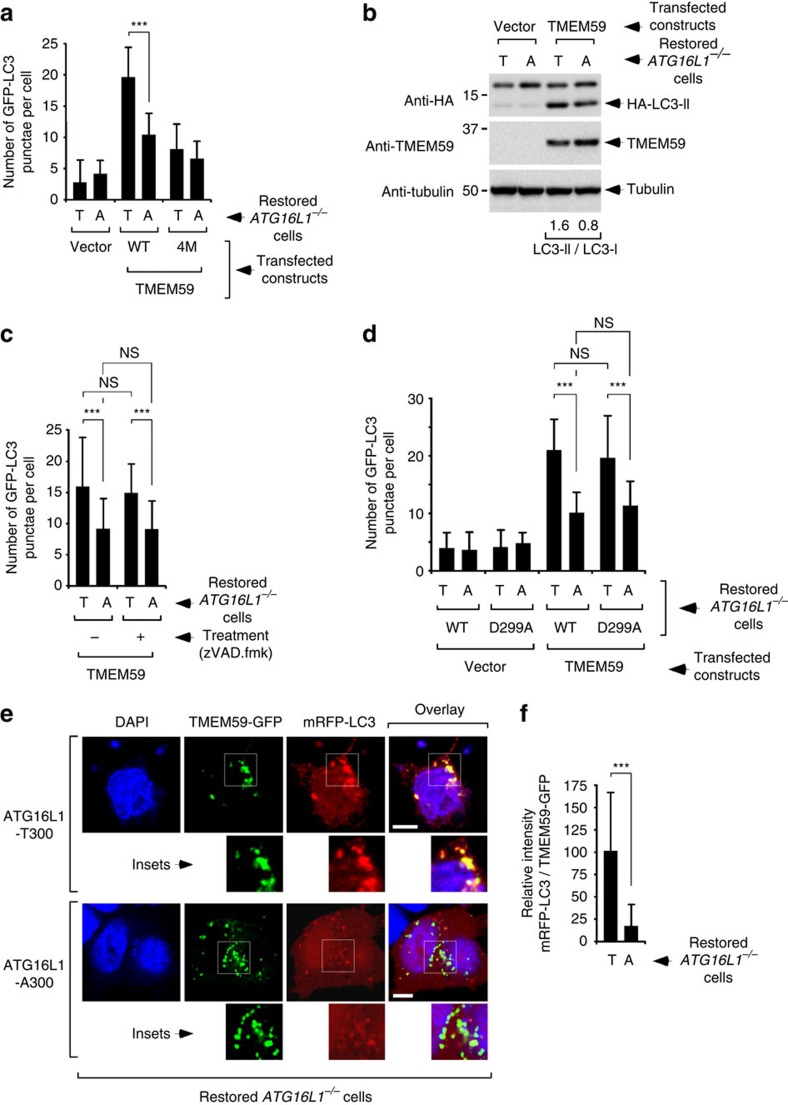
Defective autophagic function of TMEM59 in the presence of the ATG16L1-A300 Crohn's disease risk allele.(a) Quantification of GFP-LC3 punctae per transfected cell induced by TMEM59 overexpression for 24 h in ATG16L1−/− HCT116 cells restored with HA-ATG16L1-T300 (T) or HA-ATG16L1-A300 (A). Shown are mean values±s.d. (n=50 cells, ***P<0.001 Student's t-test). (b) Immunoblot analysis of HA-LC3 lipidation induced by TMEM59 overexpression in the same conditions and cell lines as in a. The LC3-II/LC3-I signal intensity ratio is shown at the bottom of the relevant lanes. (c,d) Quantification of GFP-LC3 punctae per transfected cell induced by TMEM59 overexpression for 36 h in the same cell lines as in a, and in the absence or presence of zVAD.fmk (c, 50 μM for the last 8 h of culture), or in ATG16L1−/− HCT116 cells restored with the indicated ATG16L1 mutants (d). Data are displayed as in a (NS, not significant, P>0.05 Student's t-test; ***P<0.001 Student's t-test). (e) Representative confocal pictures showing colocalization between TMEM59-GFP and mRFP-LC3 co-expressed for 36 h in the same cell lines as in a. Scale bars represent 5 μm. (f) Quantification of the intensity of mRFP-LC3 present in TMEM59-GFP-positive vesicles (mean±s.d., n=100 vesicles present in 8 cells, ***P<0.001 Student's t-test; right panel). Data are presented as a fraction of the mean value obtained in cells expressing ATG16L1-T300. All displayed results are representative of at least two independent repetitions.